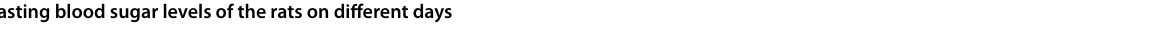
Table 2 Effect of M. charantia nanoparticles (50 mg/kg), M. charantia crude extract (100 mg/kg), silver nitrate (10 mg/kg) and metformin (100 mg/kg) on the glucose levels of the experimental rats Fasting blood sugar levels of the rats on different days